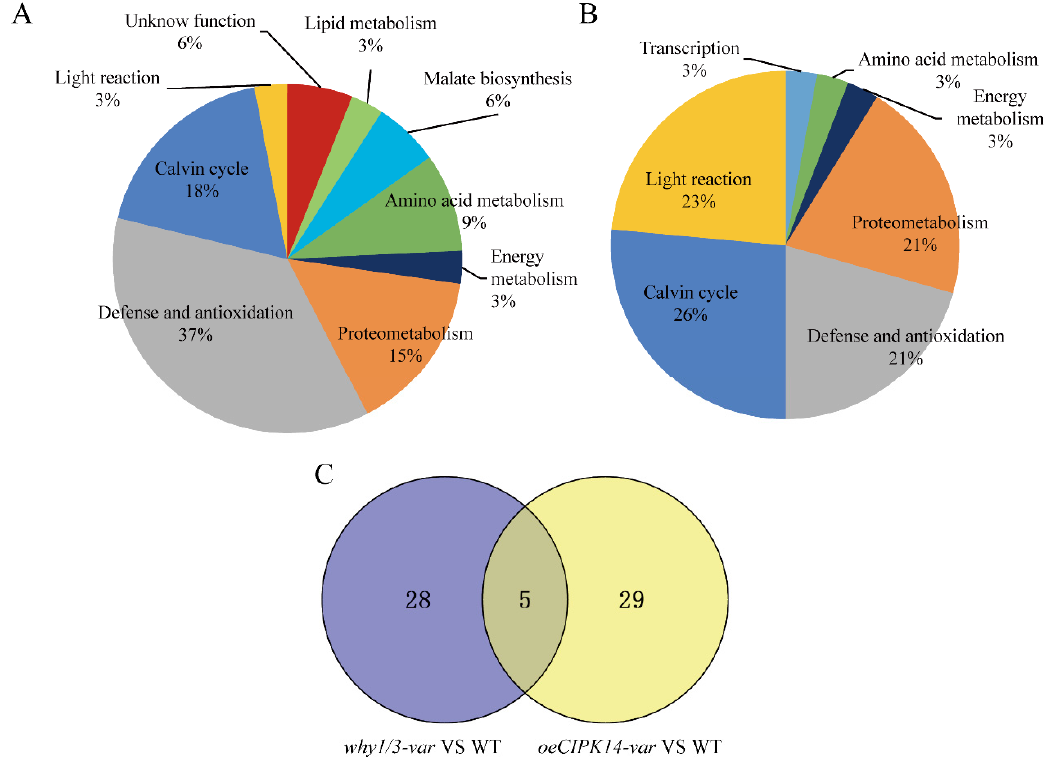
Figure 2. Functional classifications of the differentially expressed proteins identified in why1/3-var and oeCIPK14-var compared with WT. ( A ) Functional classifications of the differentially expressed proteins between why1/3-var and WT; ( B ) Functional classifications of the differentially expressed proteins between oeCIPK14-var and WT; ( C ) The Venn diagram analysis between why1/3-var and oeCIPK14-var compared with WT. The Venn diagram is completed by the online tool (available online: http://bioinfogp.cnb.csic.es/tools/venny/index.html).